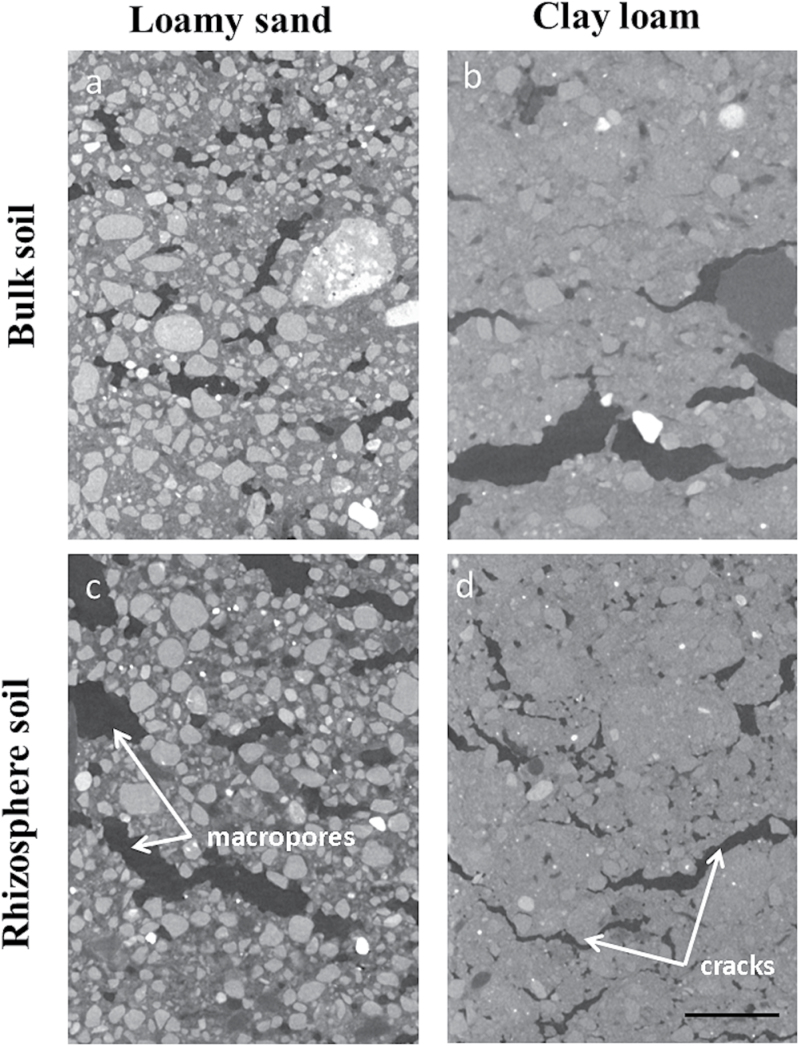
Greyscale images of bulk sand (a), clay (b) and rhizosphere sand (c), and clay (d) soils. Annotations highlight the presence of macropores in sand soil and crack formation in the clay. Scale bar=2.5mm. (This figure is available in colour at JXB online.)